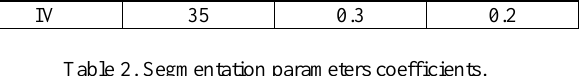
Table 2. Segmentation parameters coefficients.